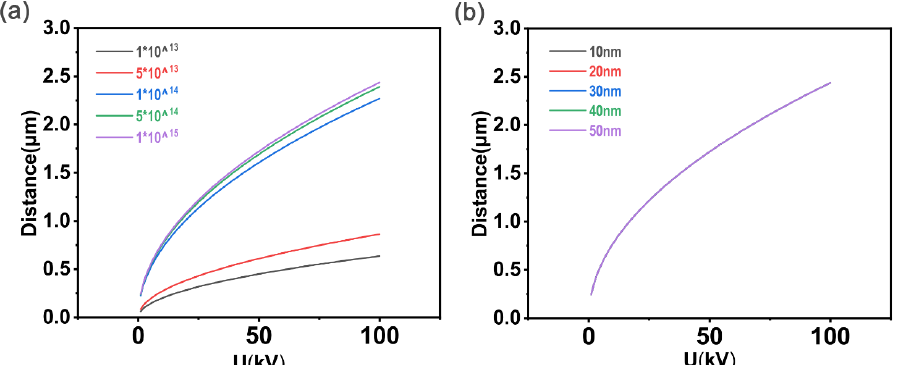
Figure 1. ( a ) r = 10 nm: the total penetration depth of the individual carbon black particle varies with the accelerating voltage. ( b ) N = 1 × 10 17 ions/cm 2 : the total penetration depth of the individual carbon black particle varies with the accelerating voltage.